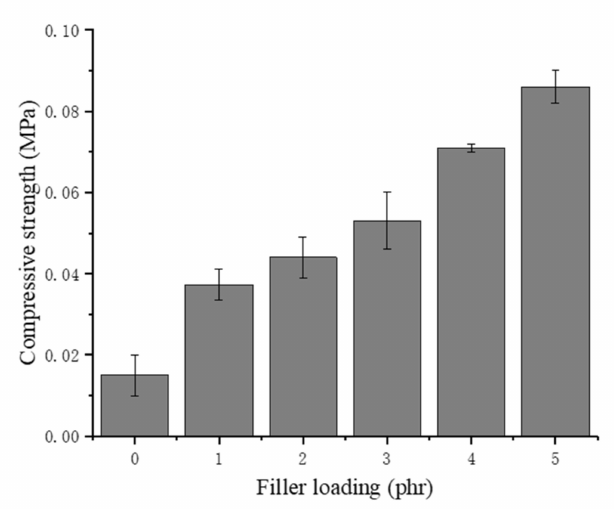
Figure 10. Compression strength of